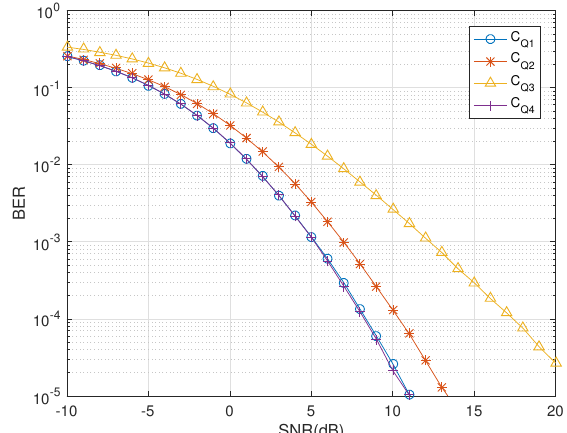
Figure 4. BER vs. SNR performance of QODs C Q